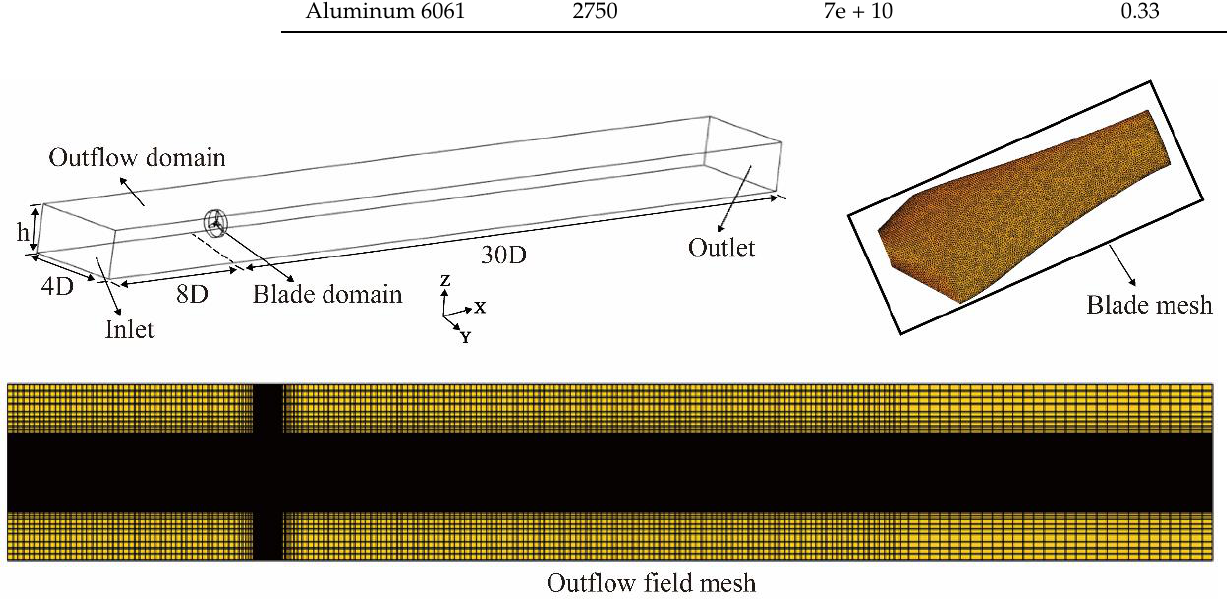
Figure 1. CFD model and the division of the mesh.